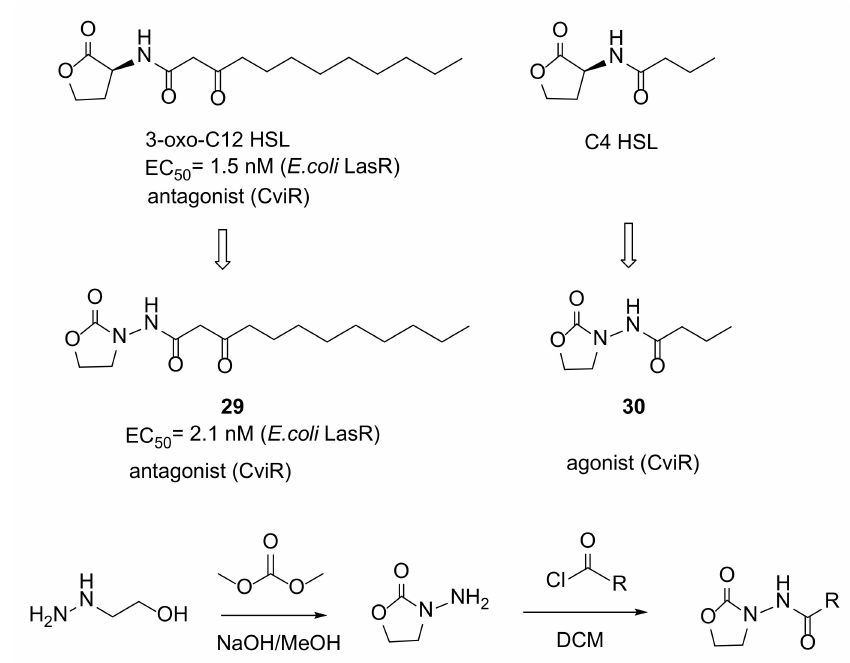
Scheme 4. 3-Aminooxazolidinone AHLs